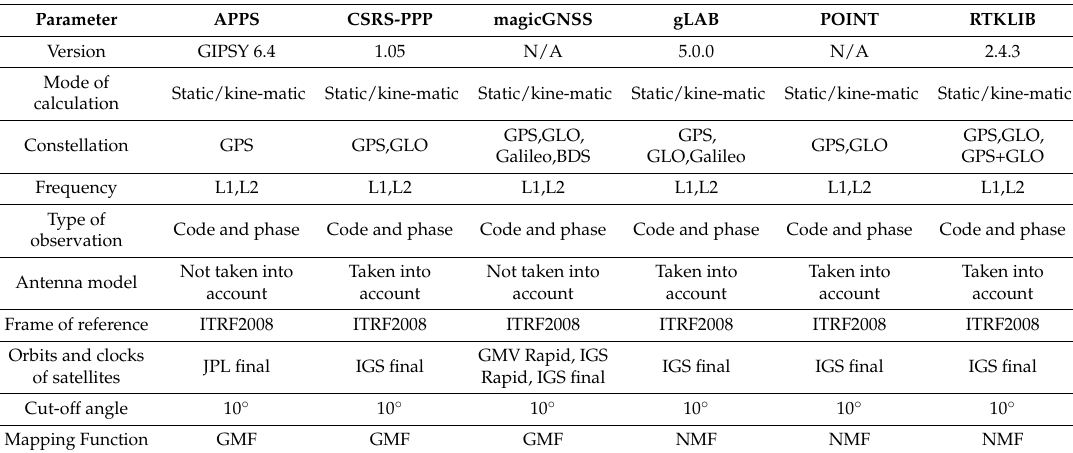
Table 1. Comparison of capabilities of the software packages used in this